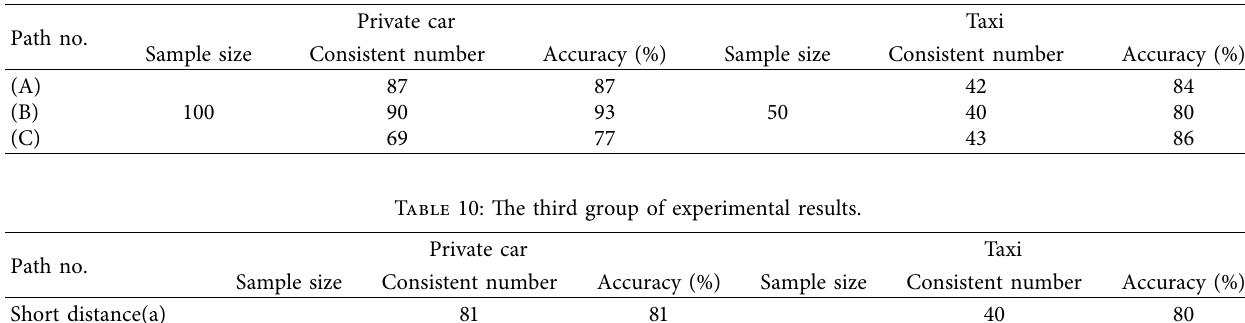
Table 9: The second group of experimental results.